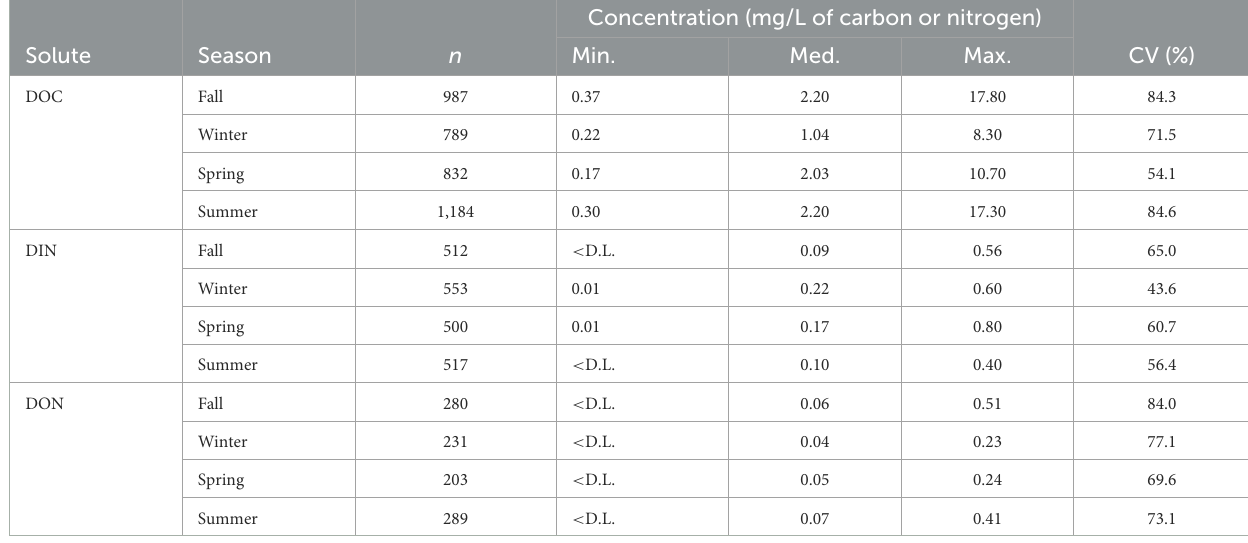
TABLE 1 Number of observations ( n ) by solutes and season and statistical information for concentration-discharge relationships.